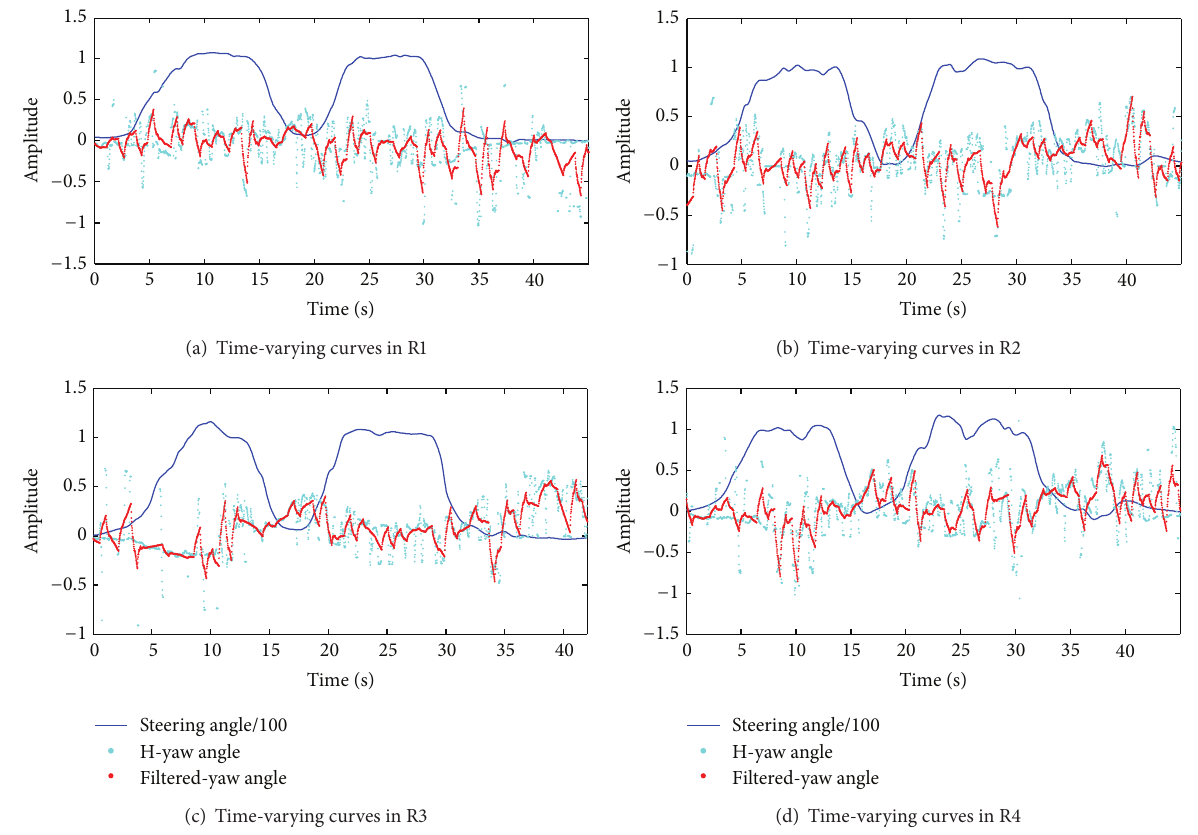
Figure 5: Steering angle and driver’s gaze direction when driving around right-hand curves.